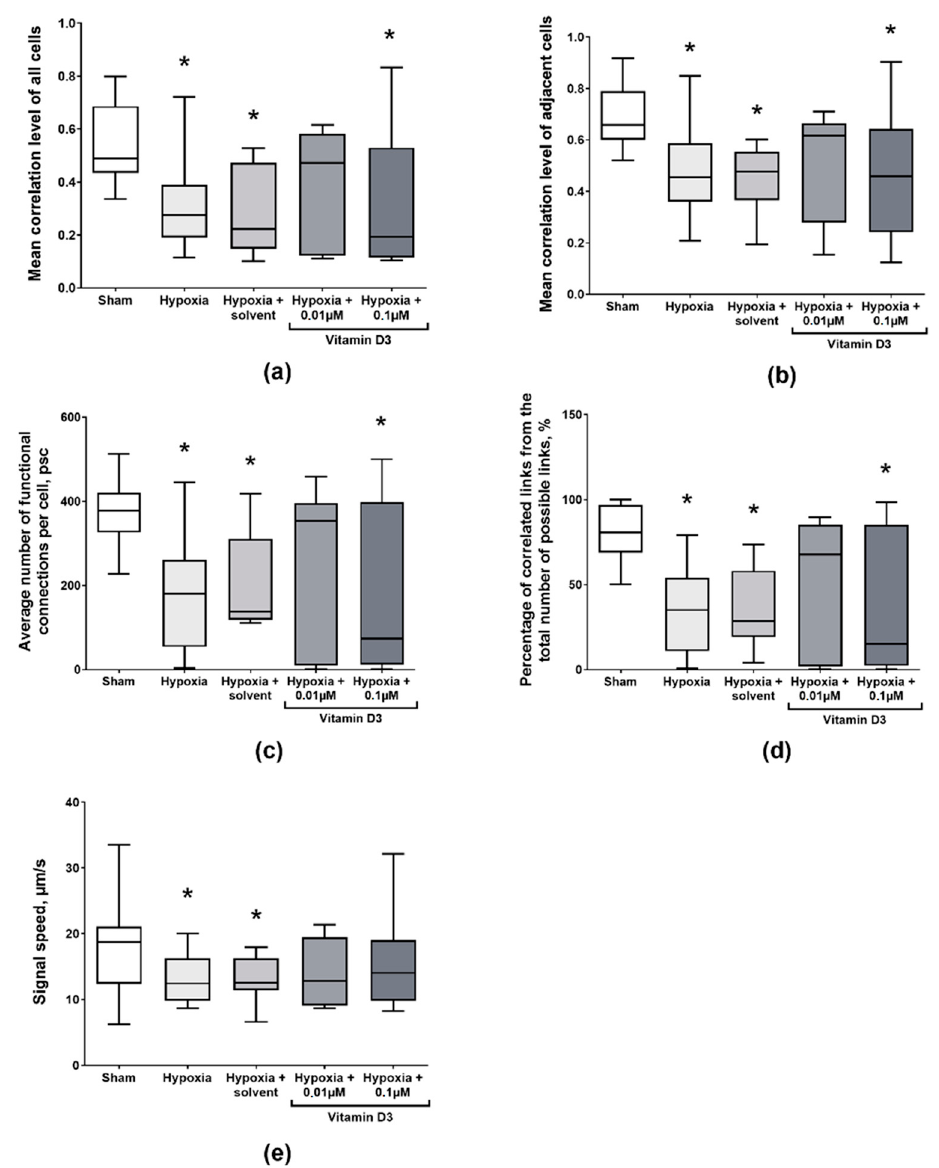
Figure 4. Main parameters of the network activity of primary neuronal cultures on day 7 of the post-hypoxic period. ( a ) Mean correlation level of all cells in the culture; ( b ) Mean correlation level of adjacent cells; ( c ) Average number of functional connections per cell; ( d ) Percentage of correlated connections from the total number of possible connections; ( e ) Signal delay rate between cells. * versus “Sham”, p < 0.05, the Mann–Whitney test.